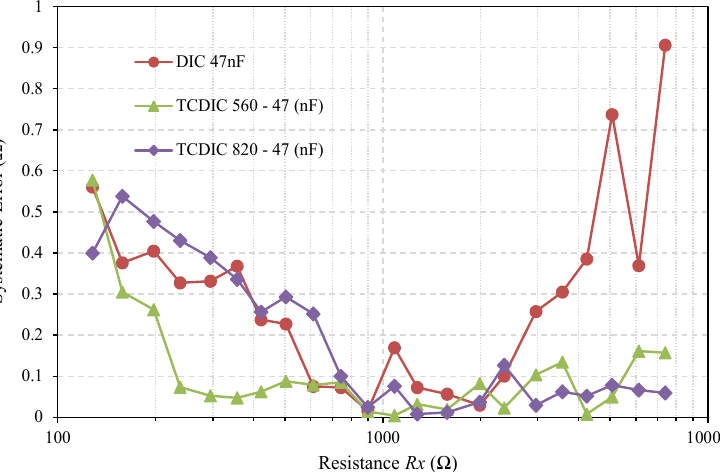
Figure 8. The systematic error in estimating Rx (calculated from 500 estimates) using a classic DIC, with C = 47 nF (red curve) and the same two TCDIC configurations as shown in Figures 6 and 7.